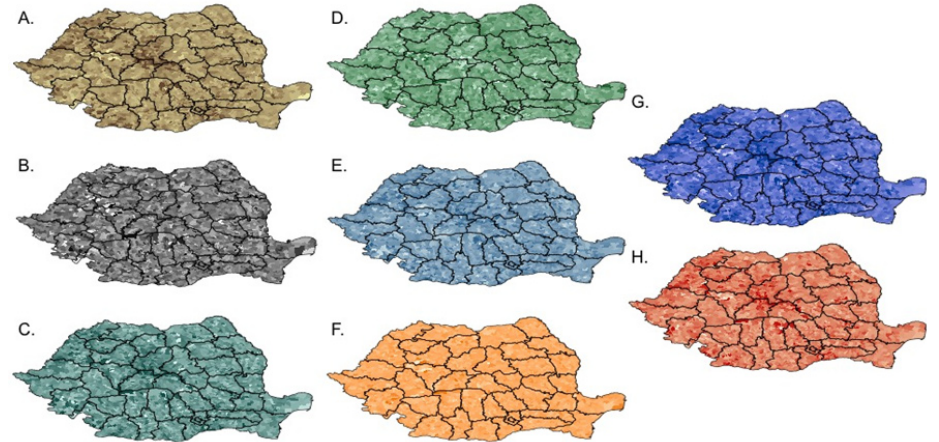
Figure 3. Visualization of quality of life parameters. A ) Lack of Electricity, B ) Severe poverty, C ) Insecure Housing, D ) Lack of ‘improved water source, E ) High incidence of diarrheal disease, F ) Urban versus rural distribution, G ) Prevalence of lack of education and H ) Cumulative risk. Following the assignment of categories to the synthetic population, we used ArcGIS to determine, at county level, what regions are most in need of development and/or government aid based on key parameters. We reduced each parameter to a binary distinction during the generation of the population, so as to simplify the visualization process, and all parameters are presented on a continuous scale using standard deviation from the mean.